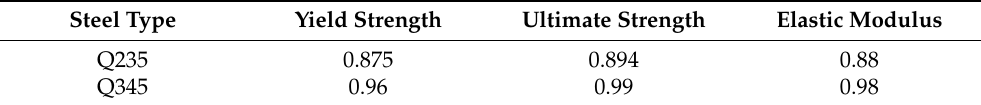
Table 8. Value of the reduction coefficient of mechanical